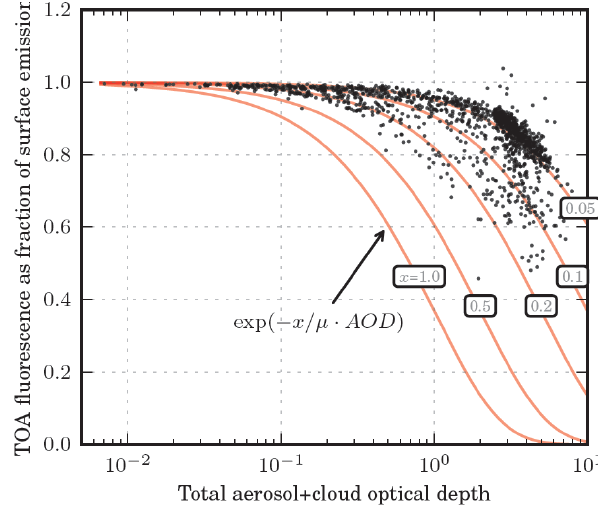
Fig. 12. Fraction of the surface fluorescence emission observed at 755nm at the top-of-atmosphere (TOA) as a function of total op- tical depth (calculated from the simulated fluorescence signal at TOA propagated through the scattering atmosphere). The dots in- dicate simulated measurements using realistic aerosols and cloud scenarios. The red lines indicate theoretical curves assuming a sim- ple exp ( − x/µ · AOD) relationship where x takes values of 1, 0.5, 0.2, 0.1, 0.05 (curves left to